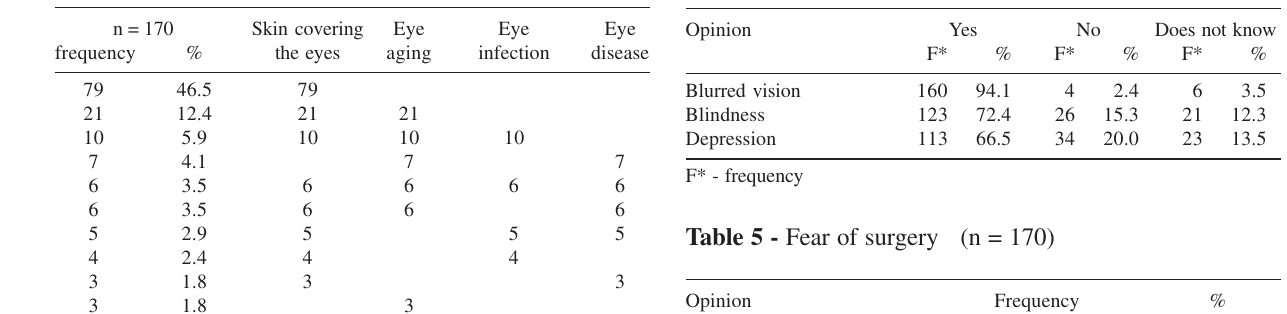
Table 4 - Opinions related to the consequences of